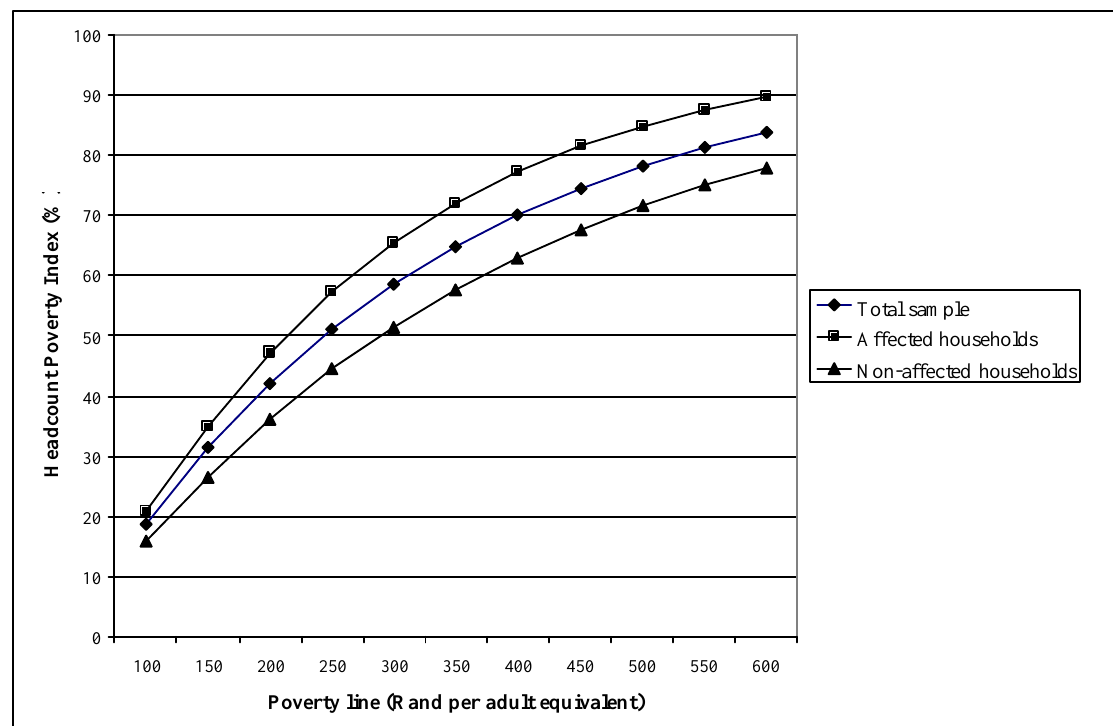
Figure 3: Incidence of poverty in affected and non-affected households (wave